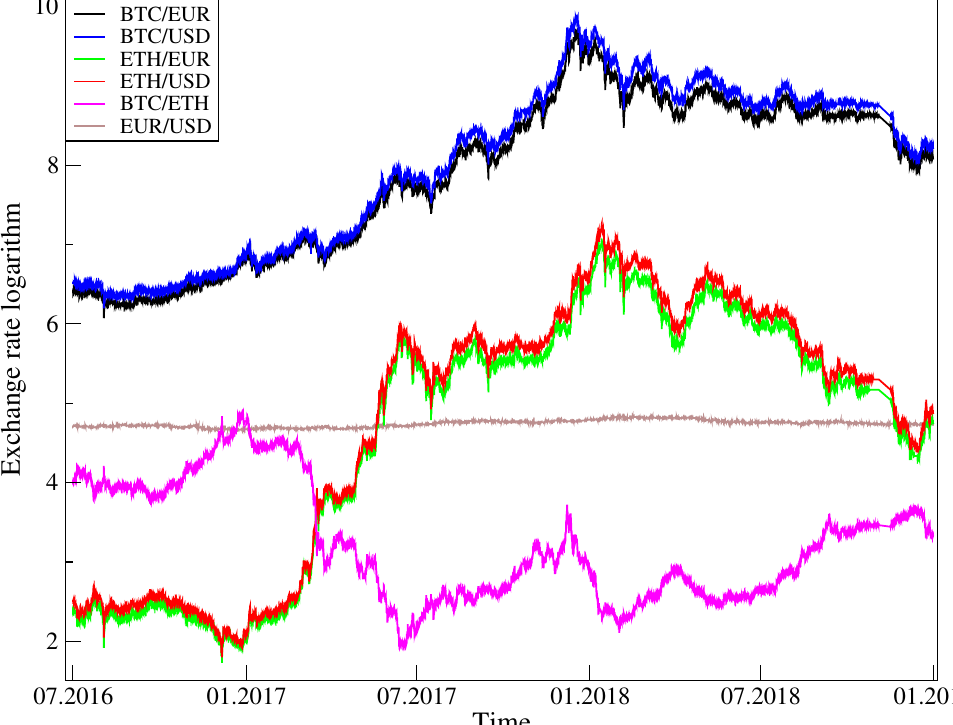
Figure 1. (Color online) Logarithm of the exchange rates BTC/EUR, BTC/USD, ETH/EUR, ETH/USD, BTC/ETH and EUR/USD over the period between 1 July 2016 and 31 December 2018. For improved visibility, the EUR/USD exchange rate was magnified by a factor of